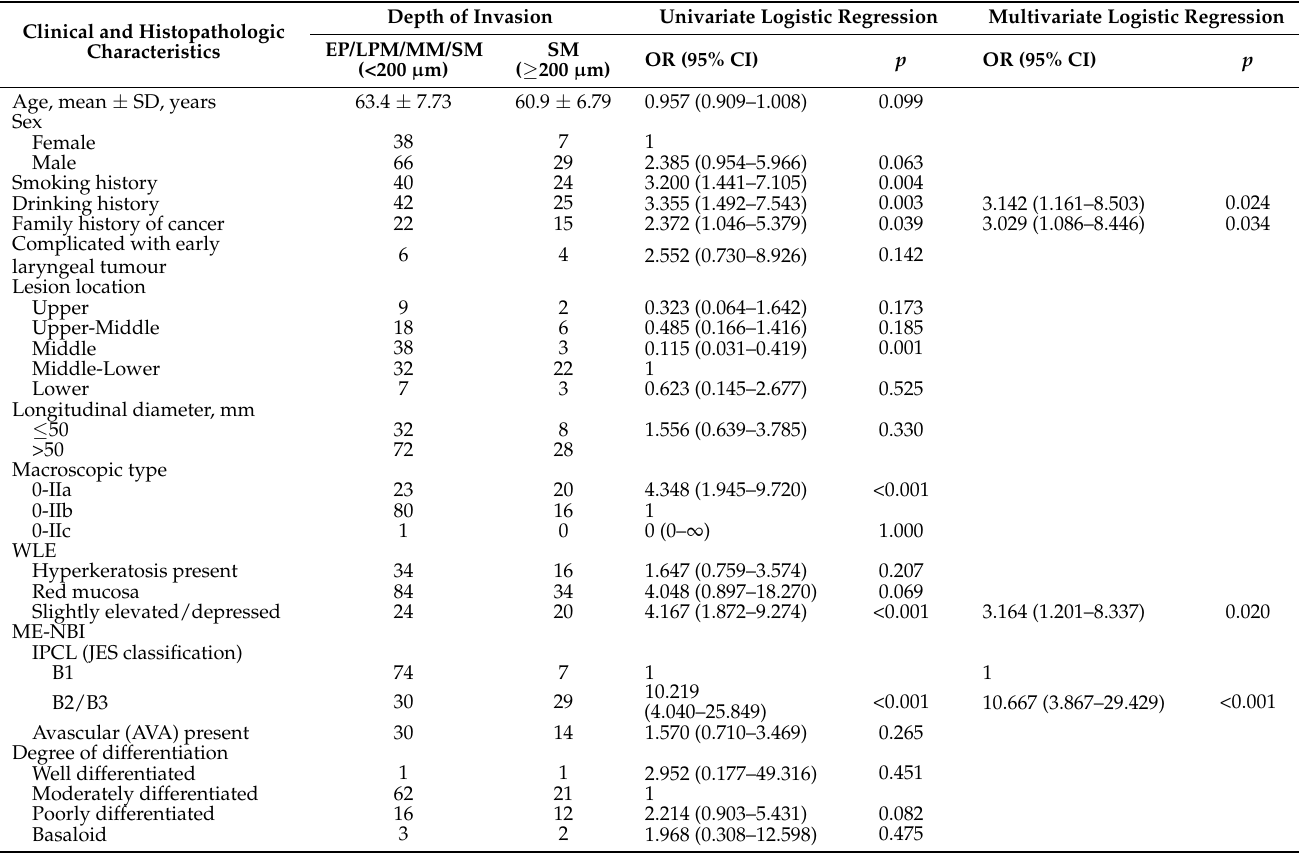
Table 1. Univariate and multivariate logistic regression analysis for depth of